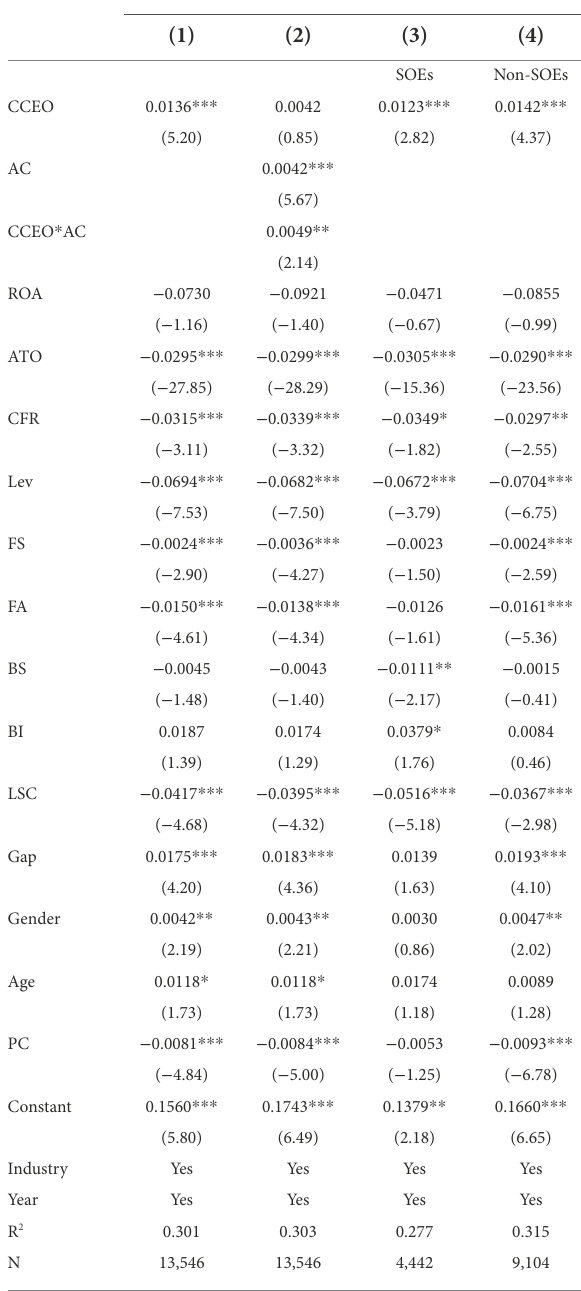
TABLE 6 Robustness test: Two-stage least squares analysis.